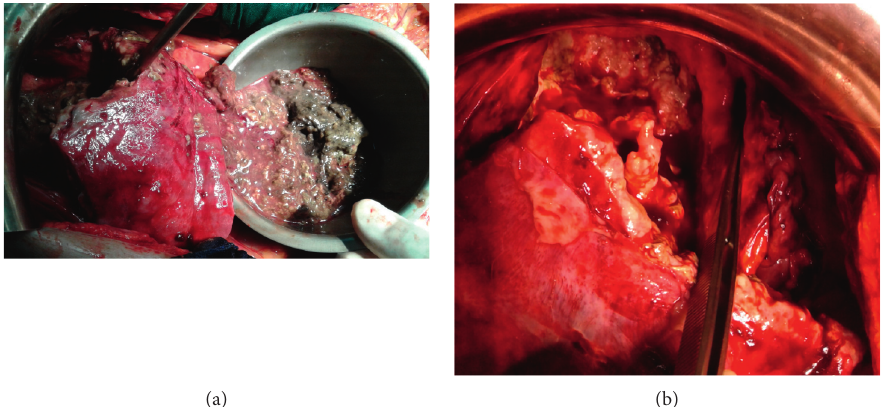
Figure 2: Operative view of the anterior surface of the left lobe of the liver showing (a) necrotic area of liver lymphoma and (b) hepatogastric